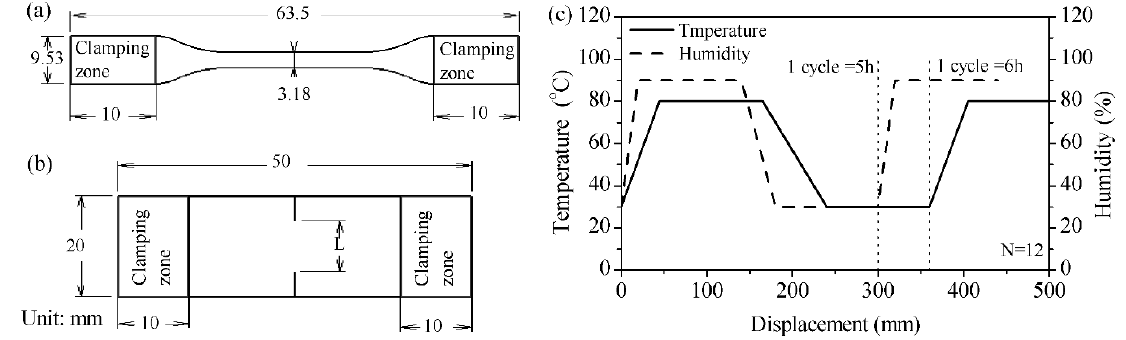
Figure 1. The dimensions of ( a ) dog-bone specimen [16] and ( b ) deeply double edge notched test (DDENT) specimen; ( c ) The curves of Humidity and Temperature cycling with one